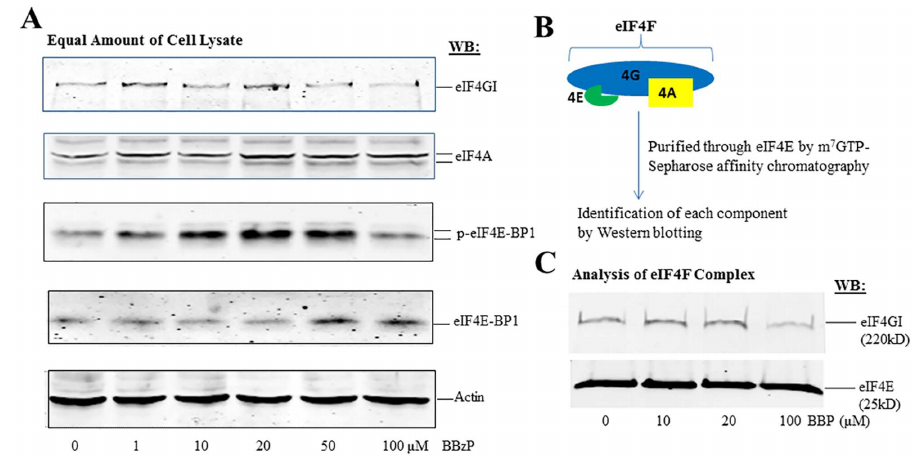
Fig 4. BBP modulates the expression and activity of eIFs in HEK-293Tcells. HEK-293T cells were culturedto 80% confluencyand treated with a series of concentrations of BBP for 24 hrs. The cells were harvestedand washedonce with cold PBS for the preparation of total cell lysate as describedin the “materials and methods”. (A) Equal amounts of cell lysate (50 μ g)were analyzedby Western blot with antibodiesagainst eIFs as indicated. (B) A diagramto show the purificationof eIF4F complex by m 7 GTP-resin affinity chromatography. (C) Analysis of eIF4G and eIF4E in eIF4F complexby Western